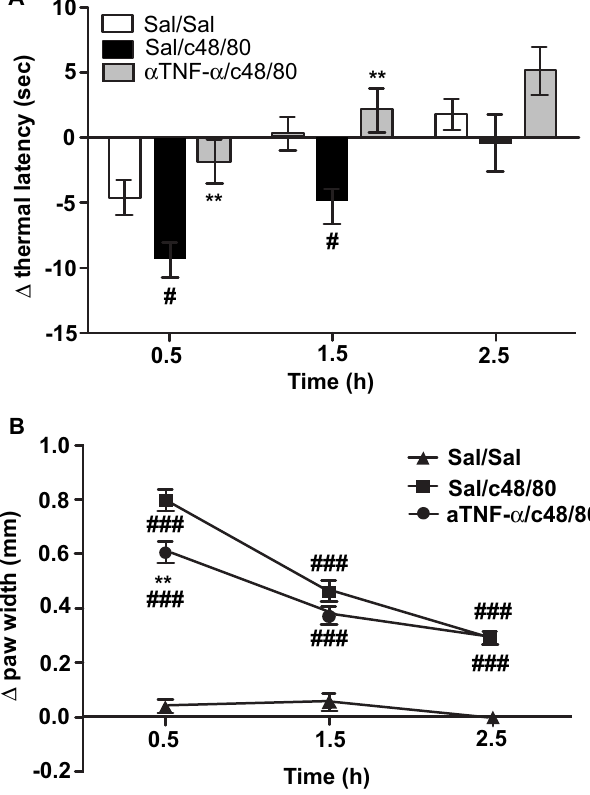
Figure 1. Anti-TNF- α neutralizing antibody abrogates c48/80- induced thermal hyperalgesia. Mice were pre-treated with 200μg/ kg anti-TNF- α neutralizing antibody or vehicle (200μ, i.v. ) 30 minutes before bilateral intra-plantar c48/80 or 0.9% saline injections (1.5μg/ paw; 10μl). The bars represent the mean change in thermal paw withdrawal latency ( A ) and the change in paw width ( B )